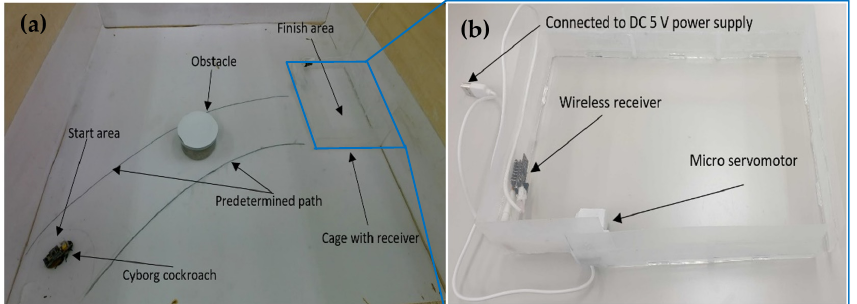
Figure 9. Photo of teleoperated biobot testbed, ( a ) experimental area for path following mission, ( b ) biobot cage. Table 1. Keyboard keys for controlling the biobot from a remote laptop in